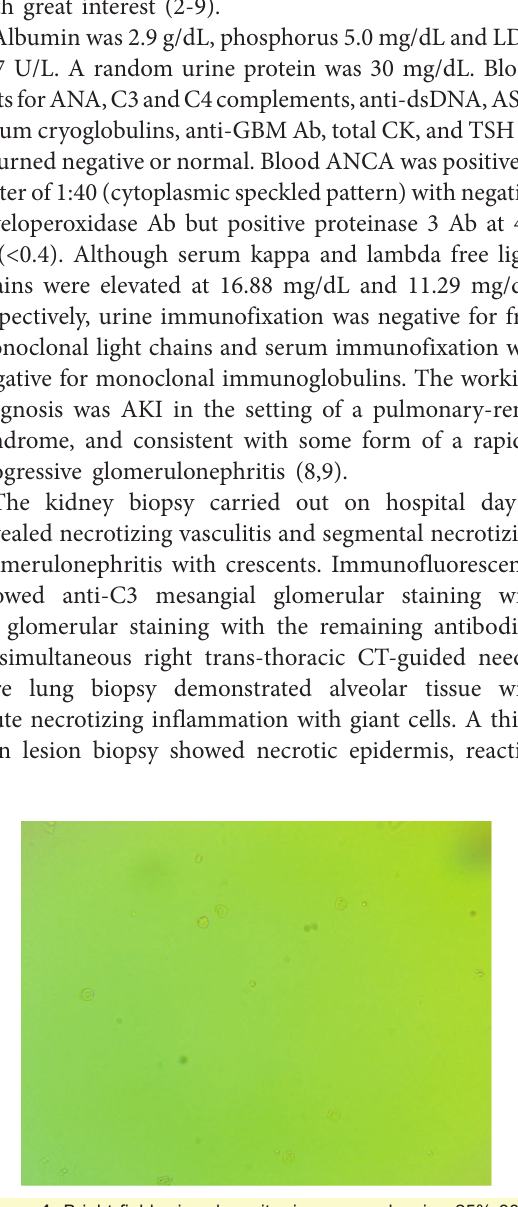
Figure 1. Bright field urine deposit microscopy showing 25%-30% dysmorphic RBCs consistent with a glomerulonephritis